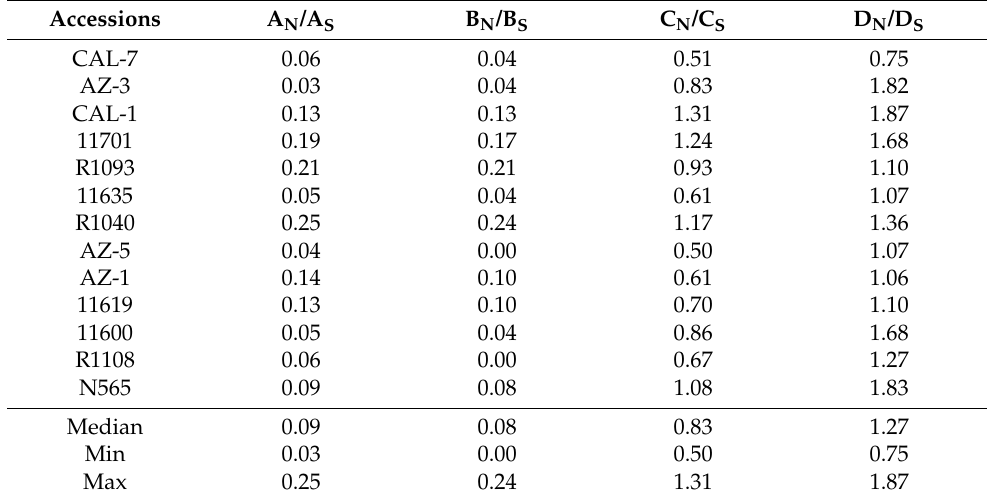
Table 2. Comparison of guayulin content in the September and November harvest for each